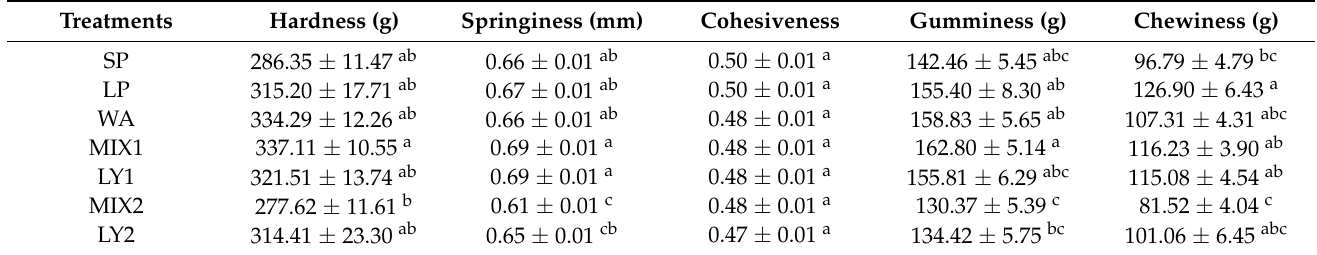
Table 6. Texture Profile Analysis (TPA) of final products. Different letters indicate significant differences among the treatments ( p ≤ 0.05). Data are average from three replicates ± standard